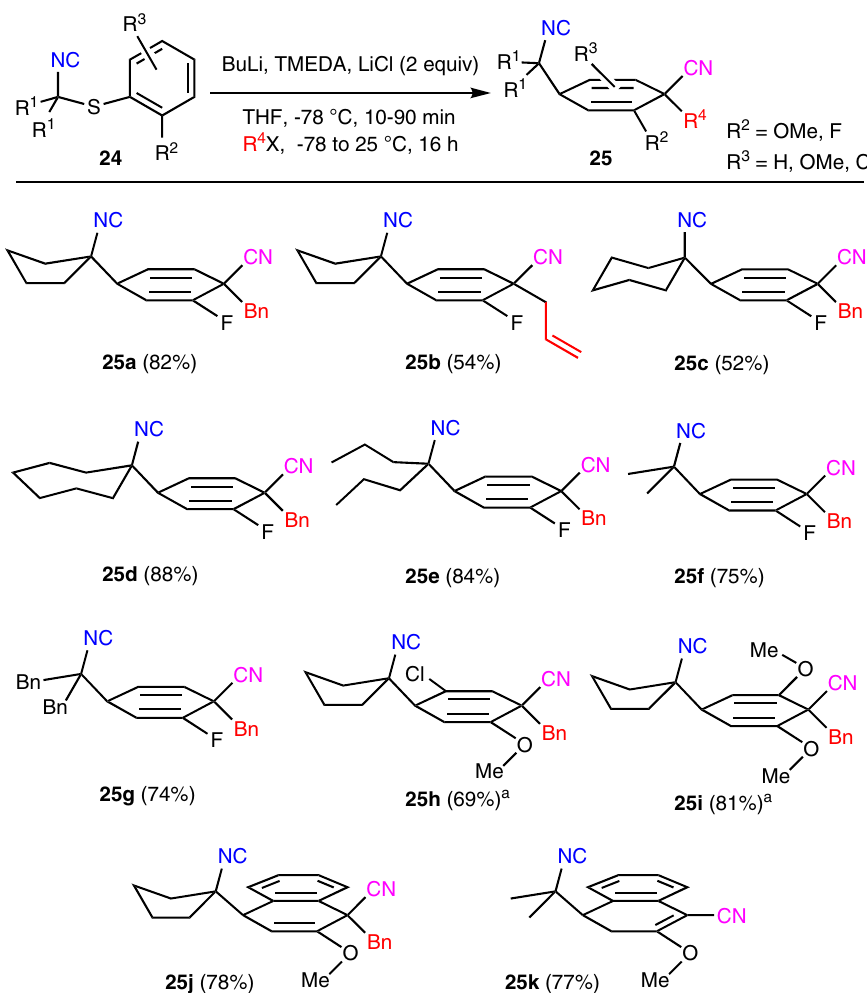
Fig. 5 | Dearomatization of aryl-substituted dialkylAsmics 24. All yields are of pure, isolated materials following chromatographic puri fi cation ( a 1.1 Equiv of HMTETA was used in place of TMEDA and